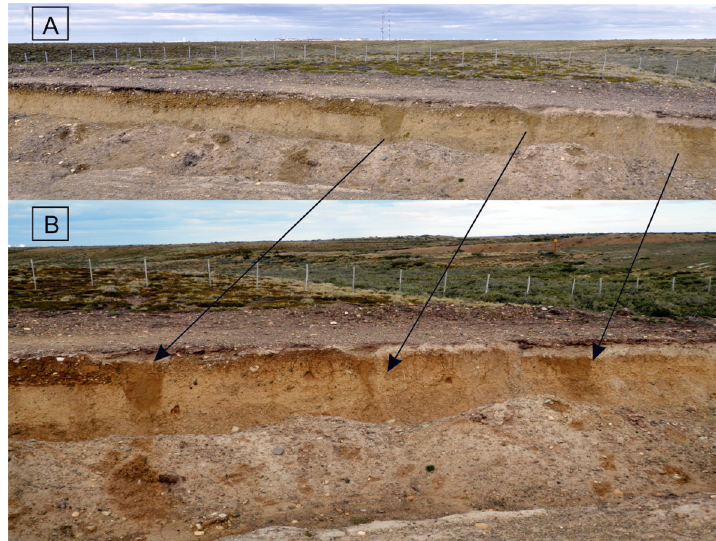
Fig. 4. view of Pampa de Beta moraine smooth relief and ice-wedges casts indicating that the region was a tundra desert during the following Pleistocene